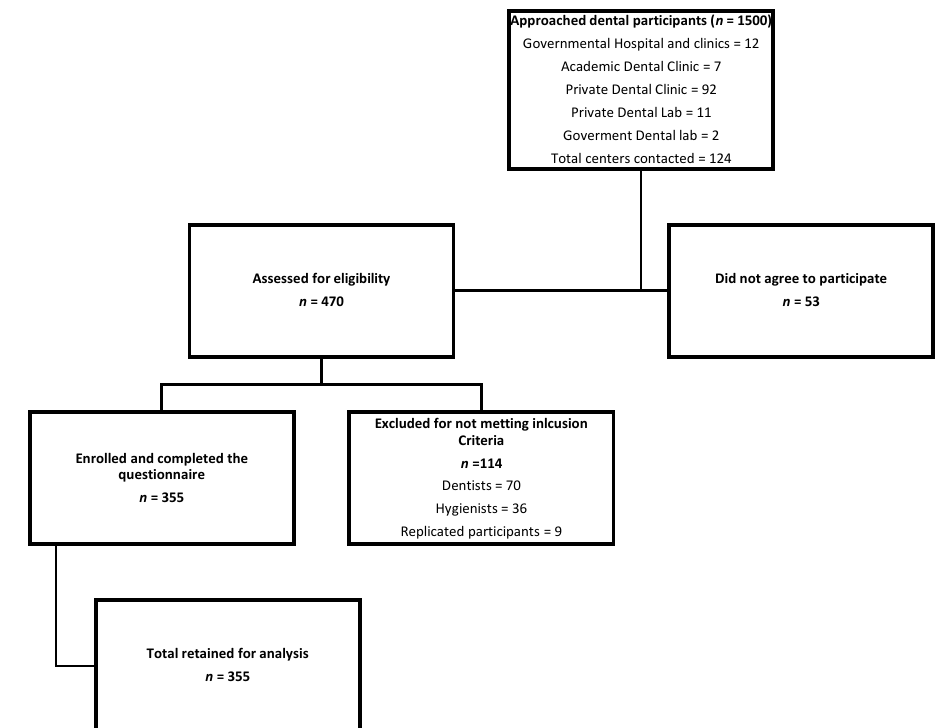
Figure 1. Flowchart of participant recruitment process.